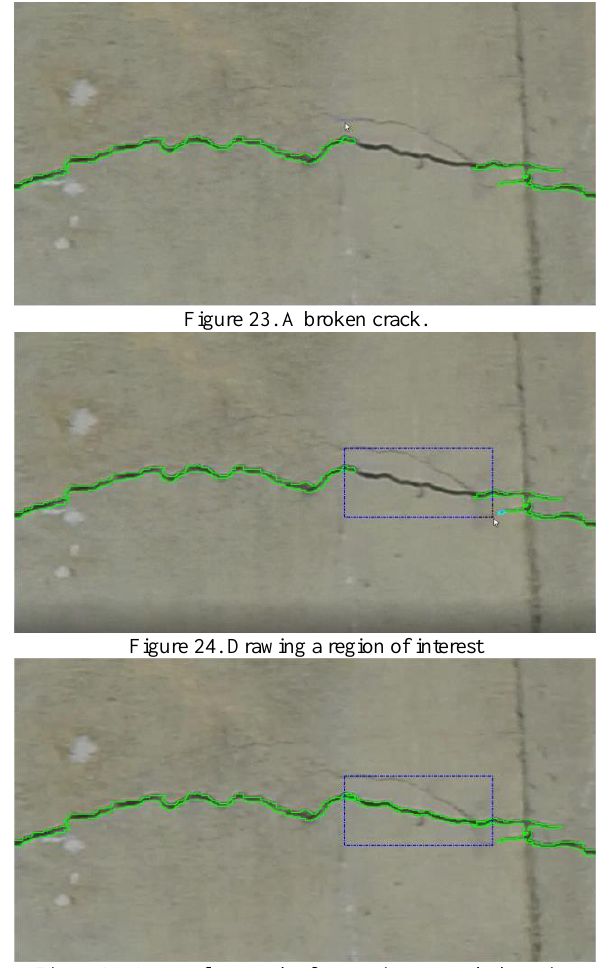
Figure 25. A complete crack after semi-auto crack